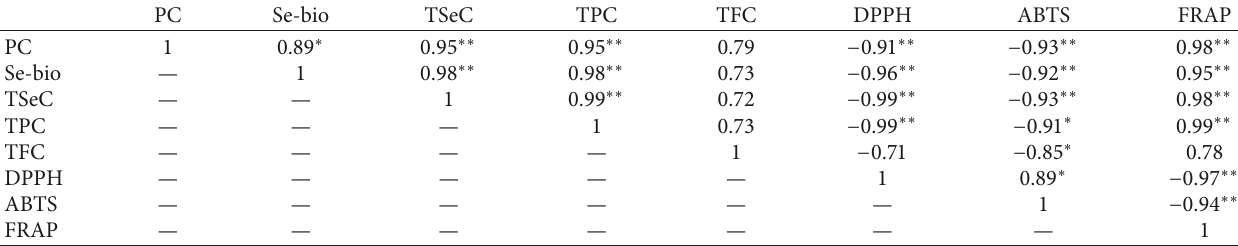
Table 3: Correlation coefficients ( r ) between difference of Se-bioaccessibility, total Se contents, and antioxidant capacity methods. PC Se-bio